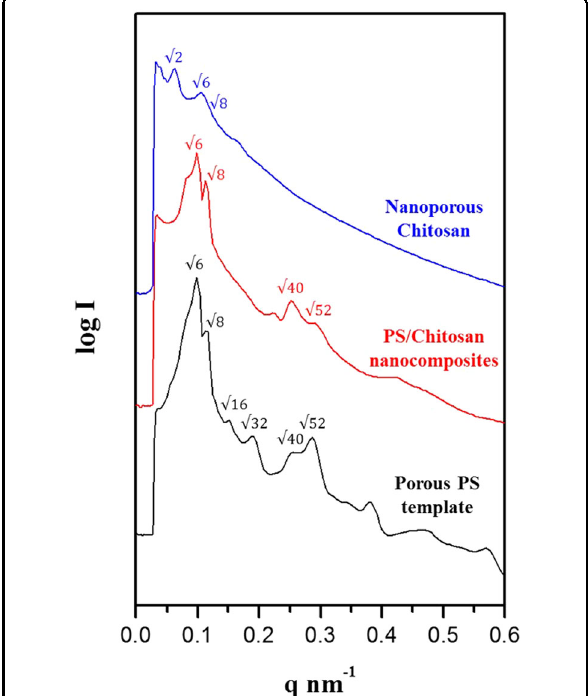
Fig. 2 1D SAXS pro fi les of the fabricated samples. 1D SAXS pro fi les of nanoporous PS template, gyroid-structured PS/chitosan nanocomposites, and chitosan nanonetworks after removal of PS